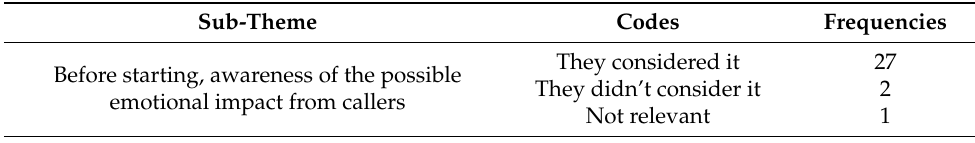
Table 4. Theme 2: “Emotional and relational impact of the helper experience”, sub-themes, codes that emerged and related